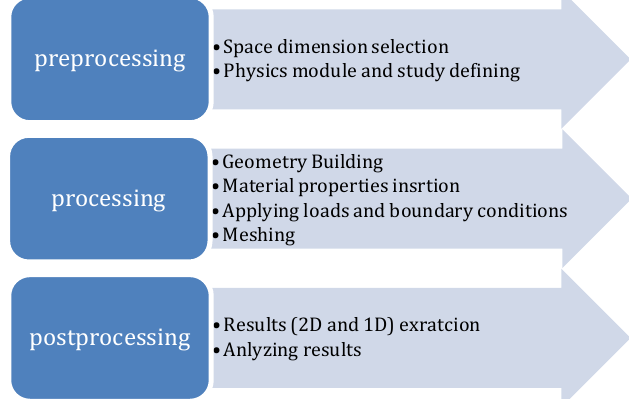
Fig. 1: Block Diagram of the COMSOL model.